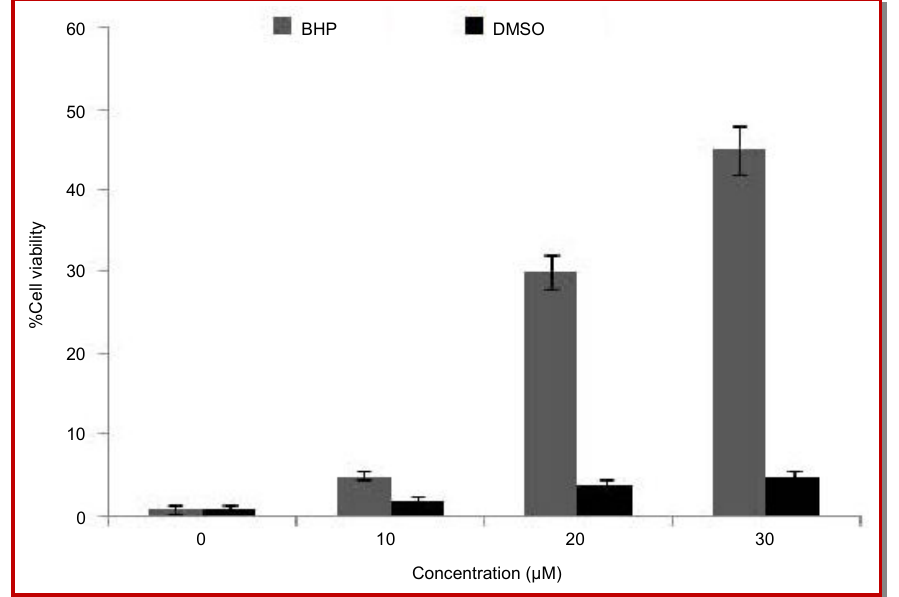
Figure 3: BHP treatment induces cell death in PC3 prostate carcinoma cells. PC3 cells treated with BHP for 48 hours followed by PI staining and flow cytotmetry analysis